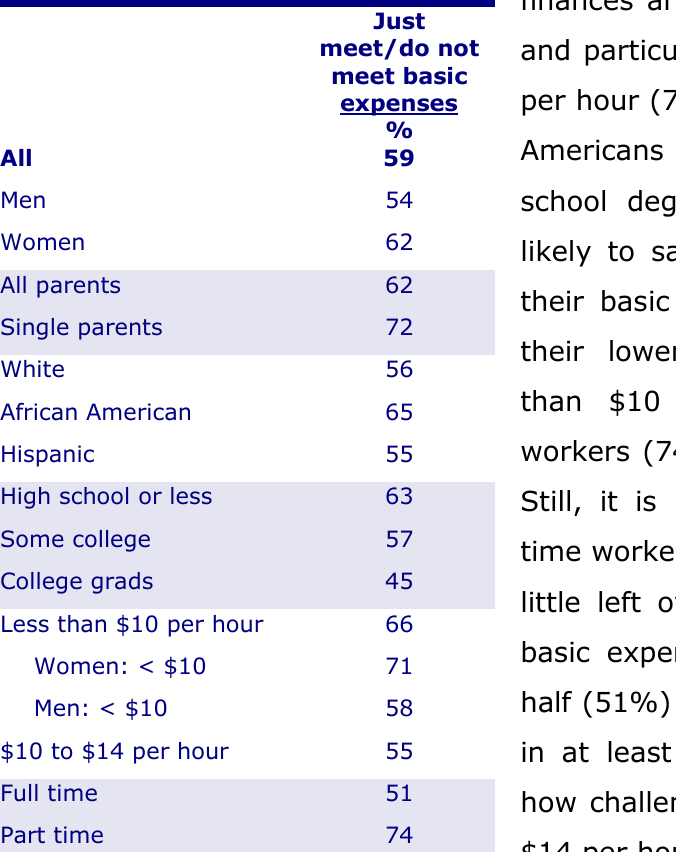
Just/Do Not Meet Basic Expenses